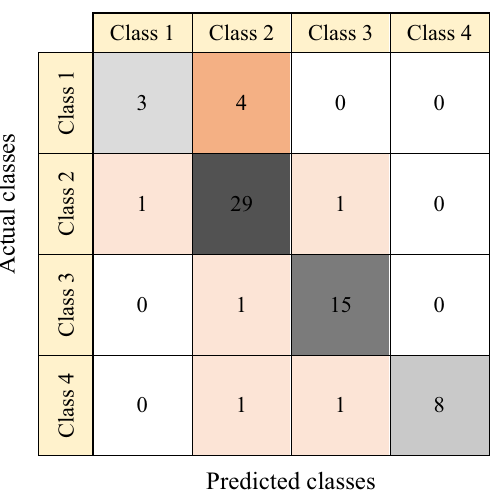
Fig. 14 Confusion matrix of support vector machine algorithm applied to data